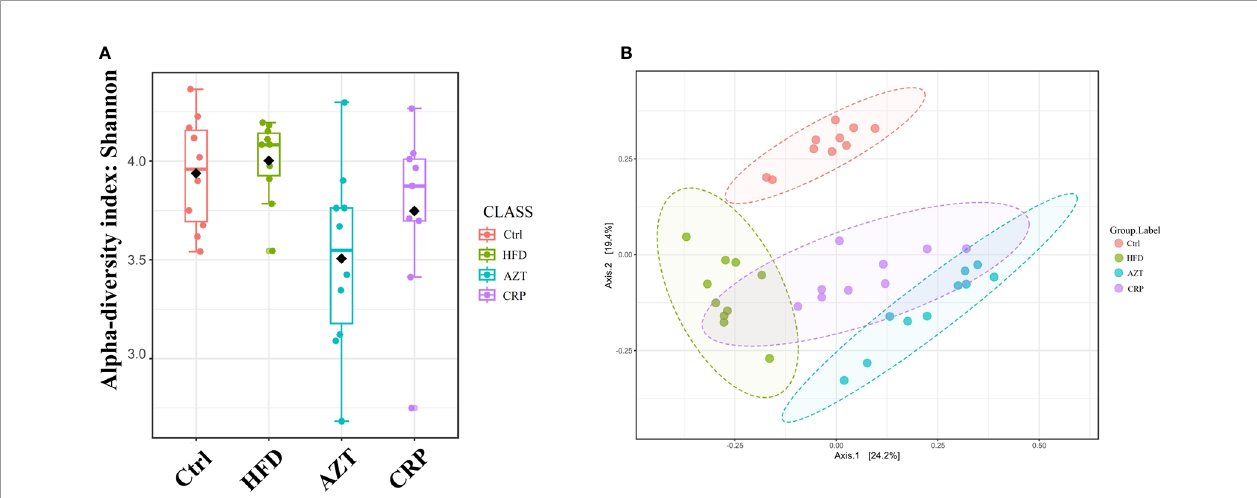
FIGURE 7 | Alpha diversity and beta diversity between the groups (n = 9 for the CRP group and n = 10 for the other groups). (A) Alpha diversity. The larger the value, the higher the community richness of the gut microbe. (B) Beta diversity. The greater the distance between the groups, the greater the difference in community